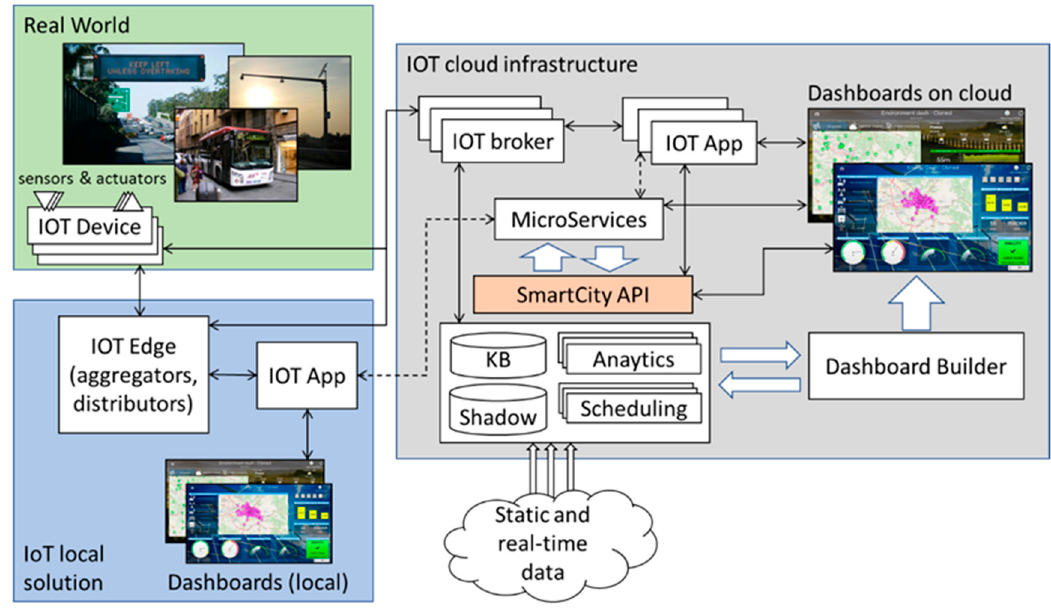
Figure 1. High level architecture of our IoT solution.